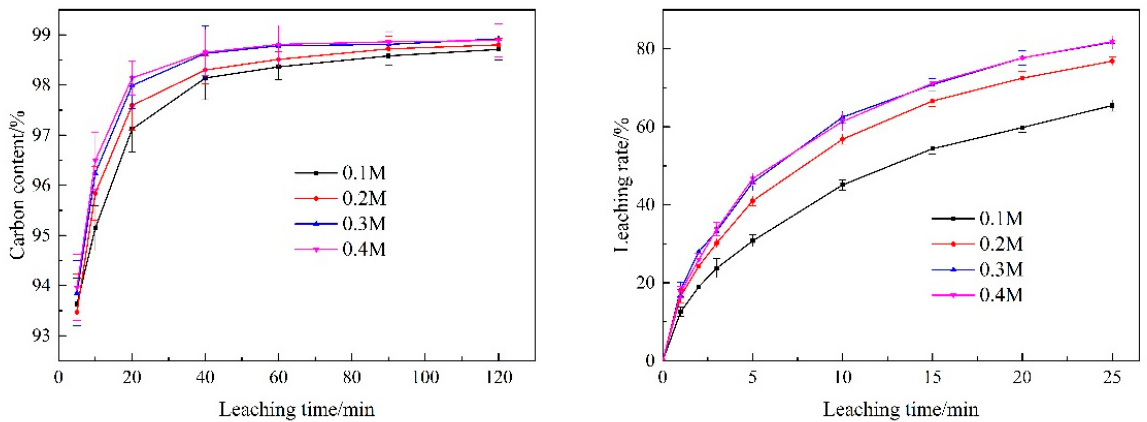
Figure 7. Effect of NaF addition on carbon content ( left ) and Al leching rate ( right ) (initial HCl concentration 4 mol/L, particle size D(50) = 67.49 μ m, 333 K).